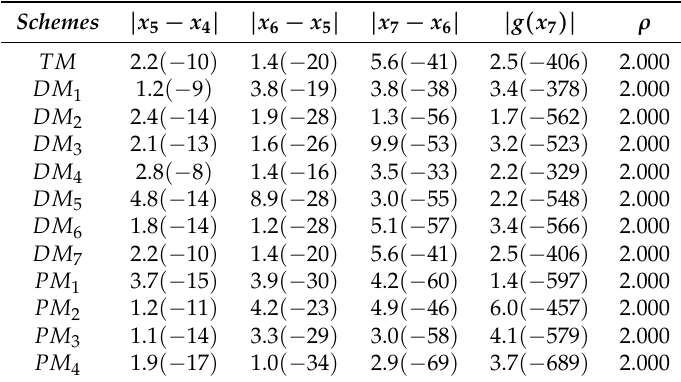
Table 7. Numerical results of Example